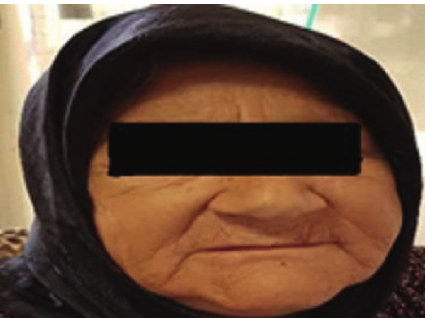
Figure 1: Alabaster-colored pale skin of patient seen in secondary adrenal